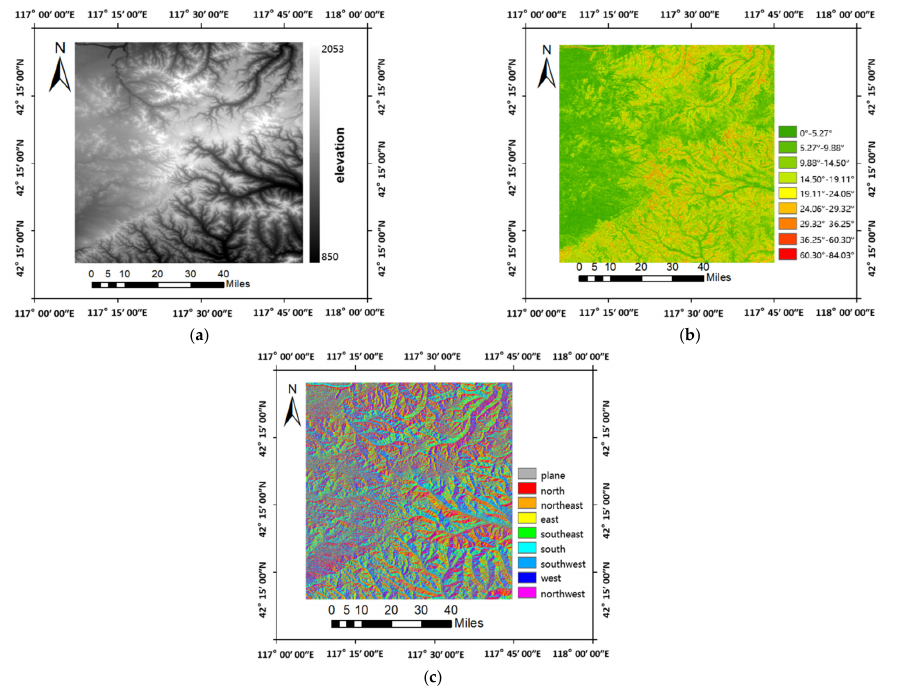
Figure 3. ( a ) Elevation; ( b ) slope; ( c )